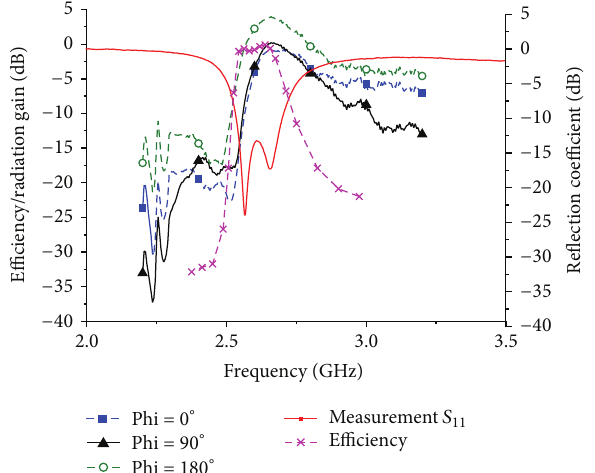
Figure 11: Radiation gain versus frequency in different directions